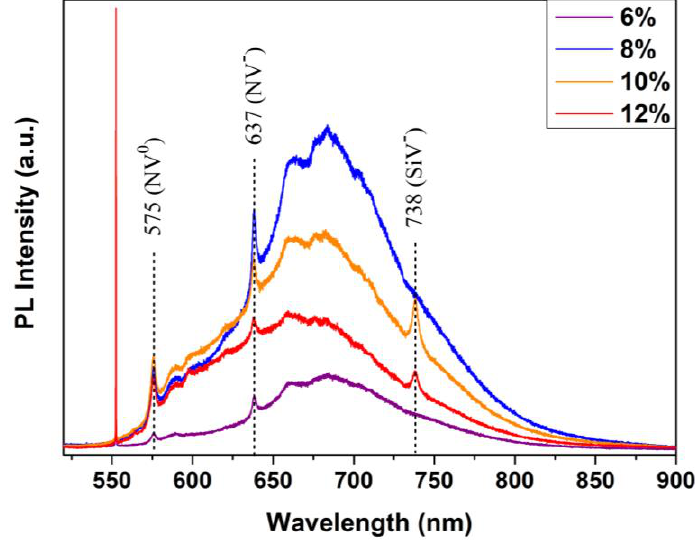
Figure 3. PL spectra at room temperature of the diamond films grown at 6%, 8%,10% and 12% CH 4 in the deposition